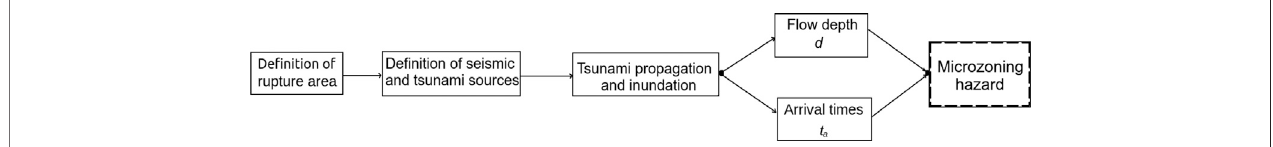
FIGURE 1 | Flowchart summarizing the overall procedure used in this